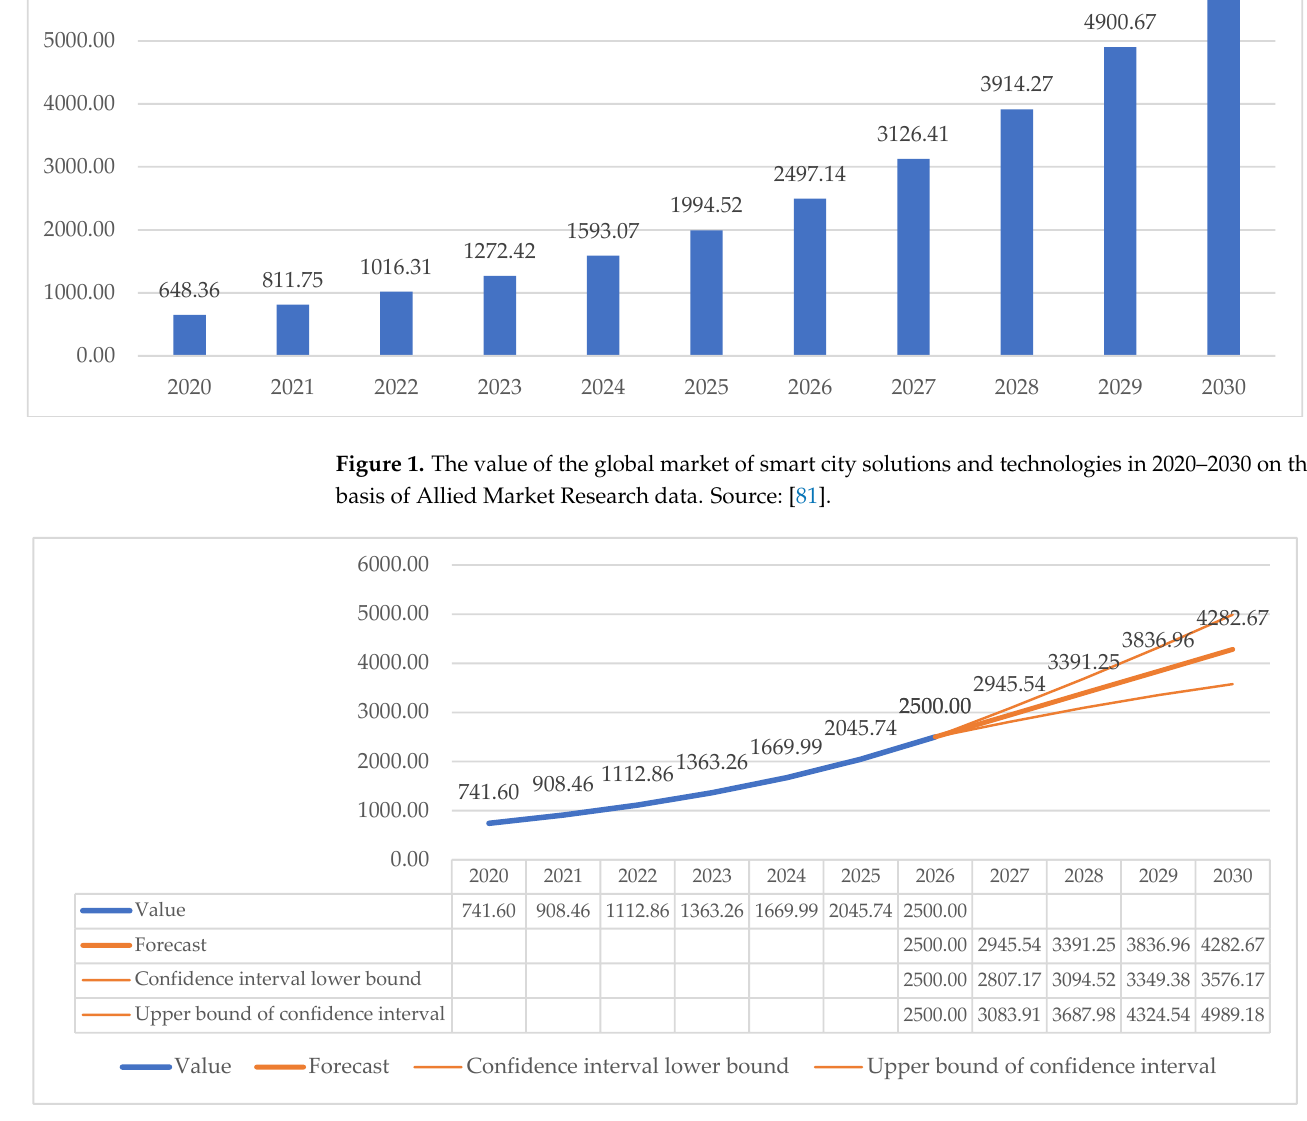
Figure 2. The value of the global market of smart city solutions and technologies in 2020 – 2030 on the basis of Research and Markets data, along with the authors’ own forecast. Source: ([82], own elaboration).